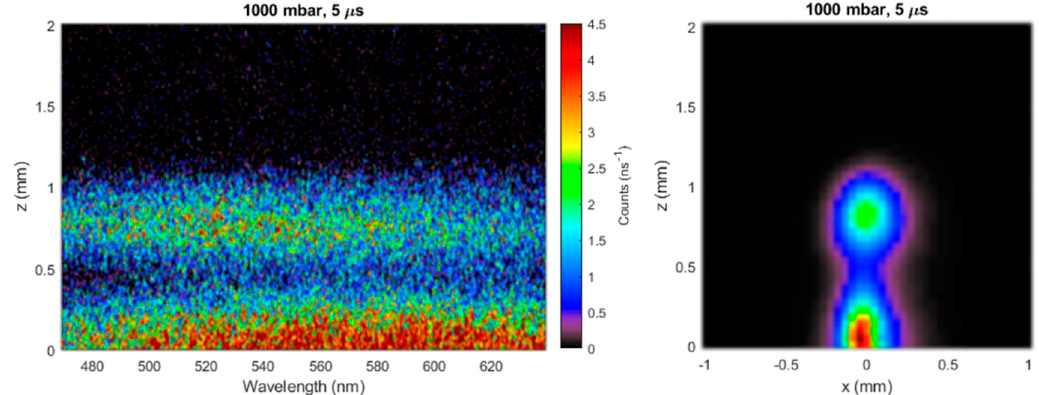
Figure 3. Space-emission spectra ( left ) of the two ablation plume features, together with the corresponding plume images ( right ), acquired at 5 μ s after the laser pulse.